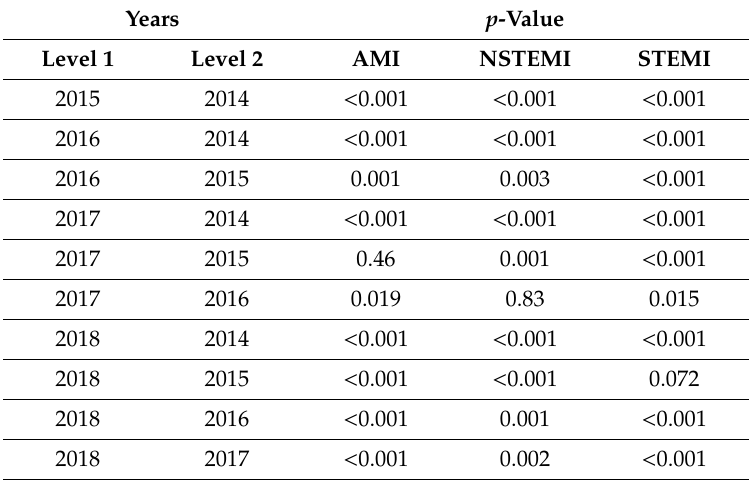
Table 1. Post-hoc analysis between frequencies of percutaneous coronary interventions with aspiration thrombectomy (PCI-TA) at selected